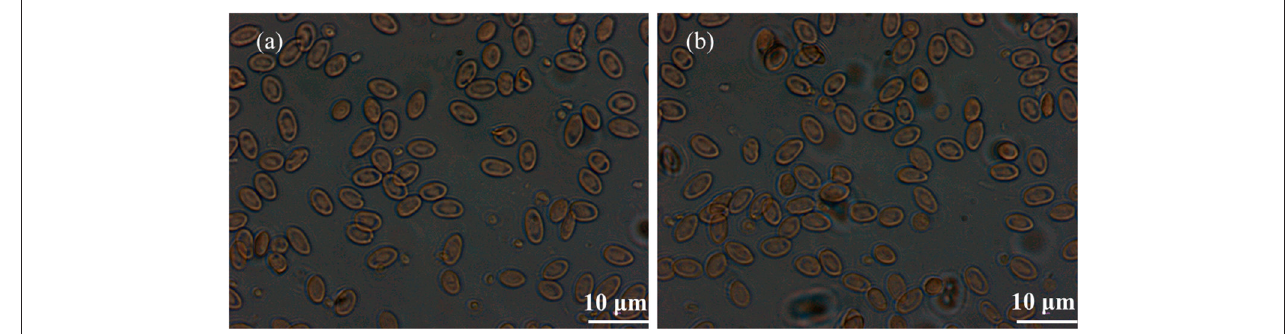
FIGURE 6 | The morphologies of RBCs captured by optical microscope: (a) the control group and (b) the BaF 2 :Nd NP dispersion group.